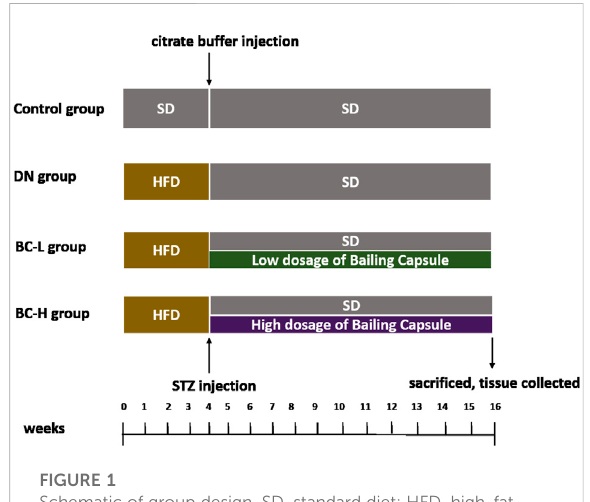
FIGURE 1 Schematic of group design. SD, standard diet; HFD, high-fat diet; DN, diabetic nephropathy; BC-L, low dosage of Bailing Capsule; BC-H, high dosage of Bailing